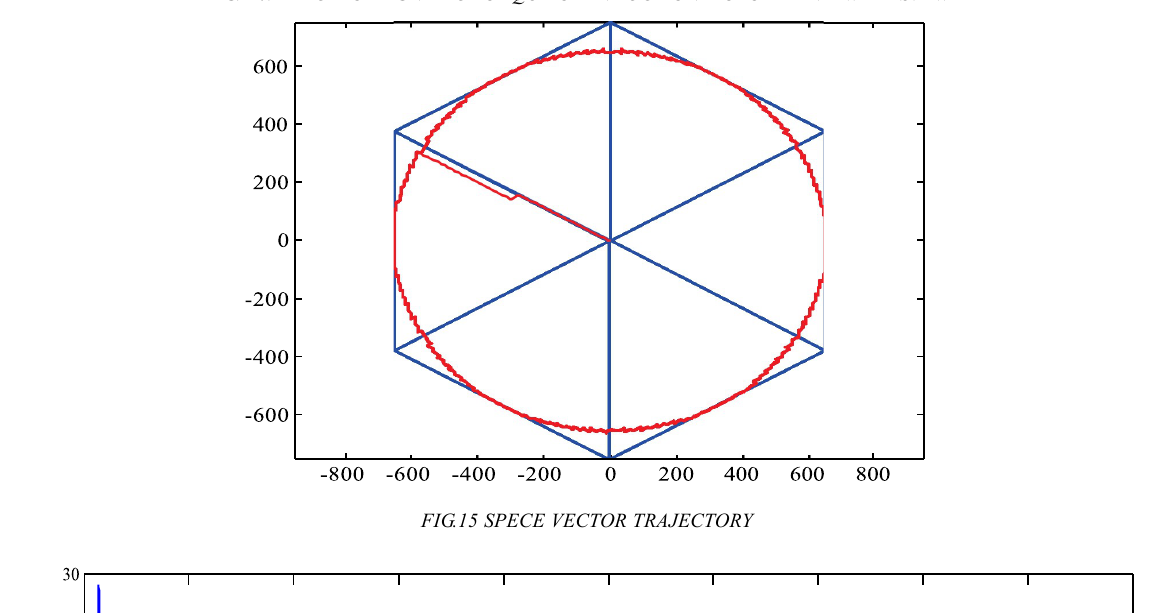
FIG. 14. ELECTROMAGNETIC TORQUE OF INDUCTION MOTOR DRIVE WITH SVPWM